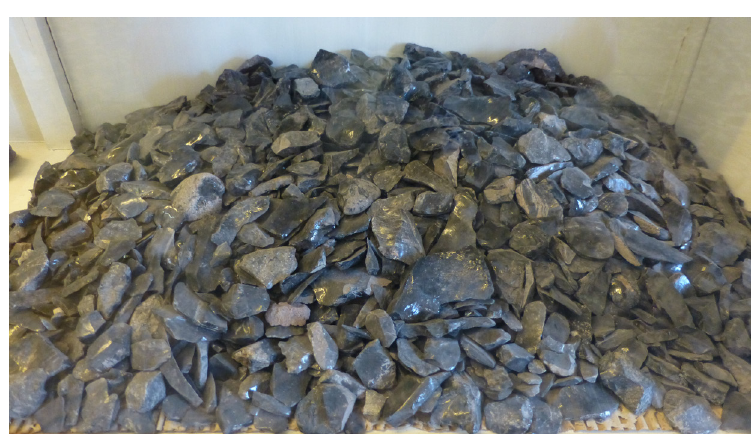
Figure 10. An obsidian assemblage from